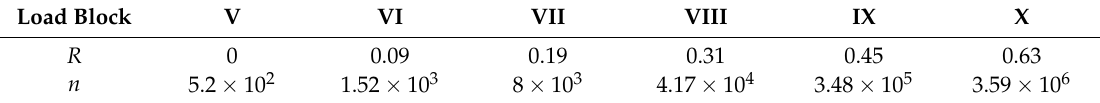
Figure 15 . Simplified load spectrum based on TWIST [10]. Table 6. Fatigue data for each load block for the simplified load spectrum based on TWIST [10].